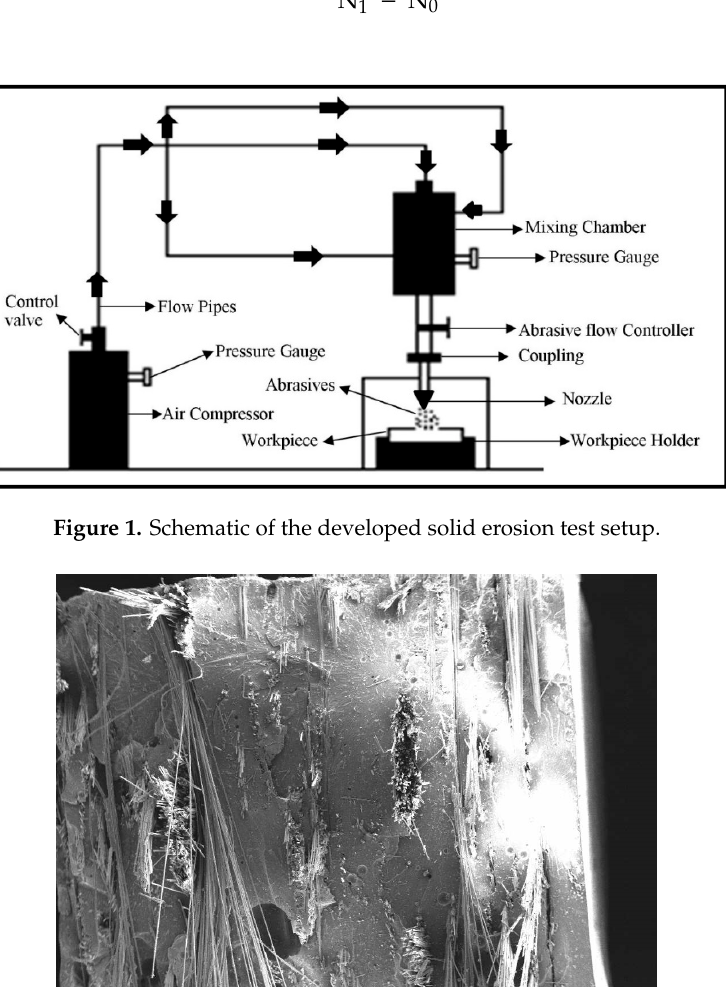
Figure 3. SEM of river sand particles. 3. Response Surface Methodology Response surface methodology (RSM) explores the association among numerous process parameters with the response parameter. The observational model is generated by using f numerical and geometric techniques. The generated model is used to improve the response reaction, which is prejudiced by several input parameters. In this paper, the Box–Behnken design was adopted for